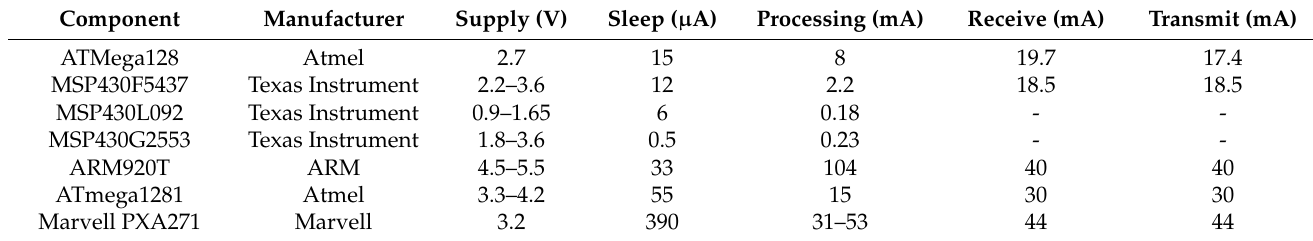
Table 5. Features of some low power marketed